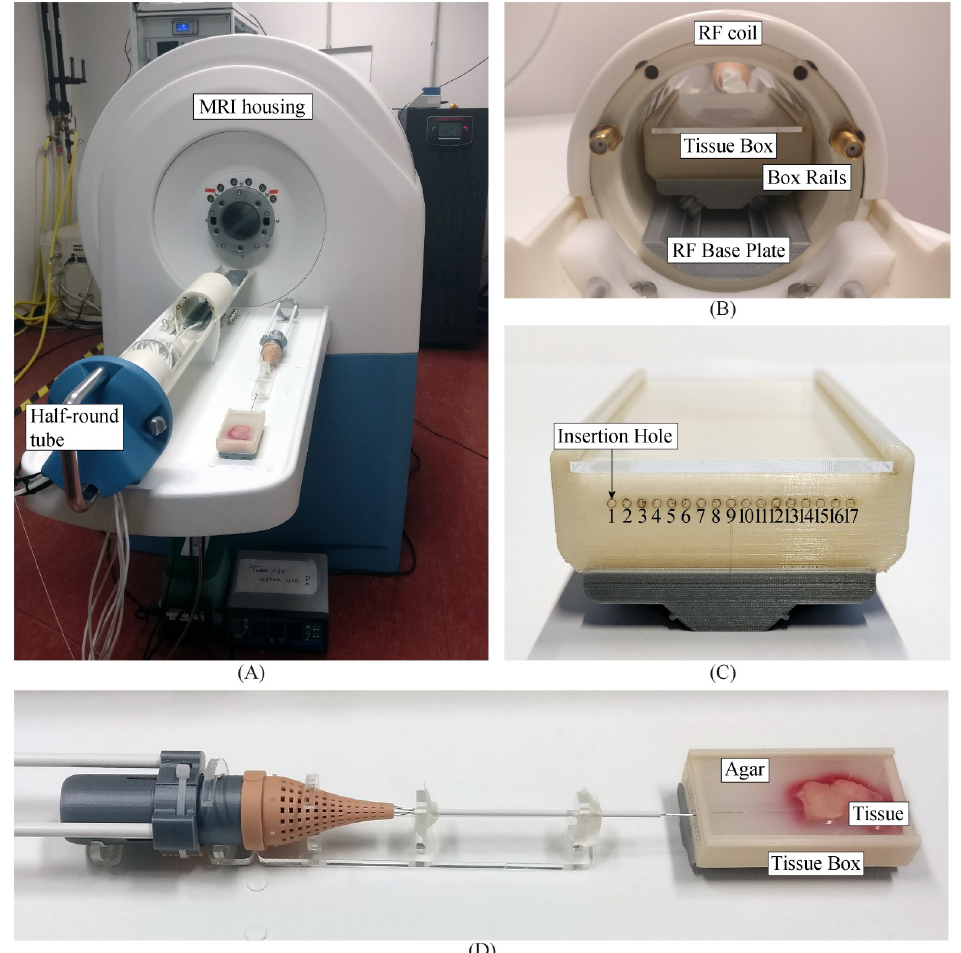
Fig 8. Experimental setup of the ex vivo prostate tissue experiment. (A) The instrument was placed in a half-round tube with a support structure in between. The half-round tube was slid into the MRI bore. (B) Close-up of the radiofrequency (RF) coil with the tissue box on the RF base plate, guided on rails. (C) Close-up of the proximal side of the tissue box containing seventeen insertion holes. (D) Close-up of the ex vivo prostate tissue embedded in solidified 2.5%wt agar, with the needle inserted through the agar in front of the tissue.